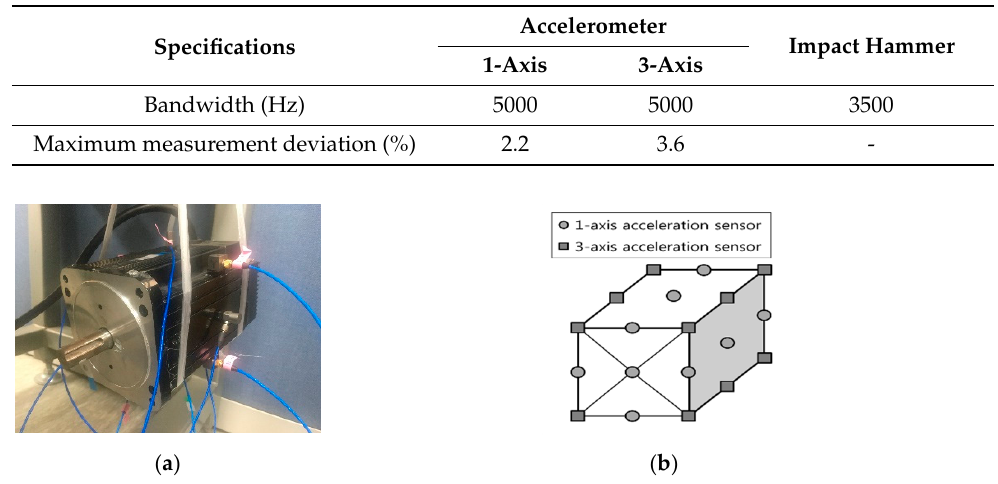
Figure 5. Modal test of the BLDC motor. ( a ) sensors attached to the BLDC motor; ( b ) sensor attachment points.